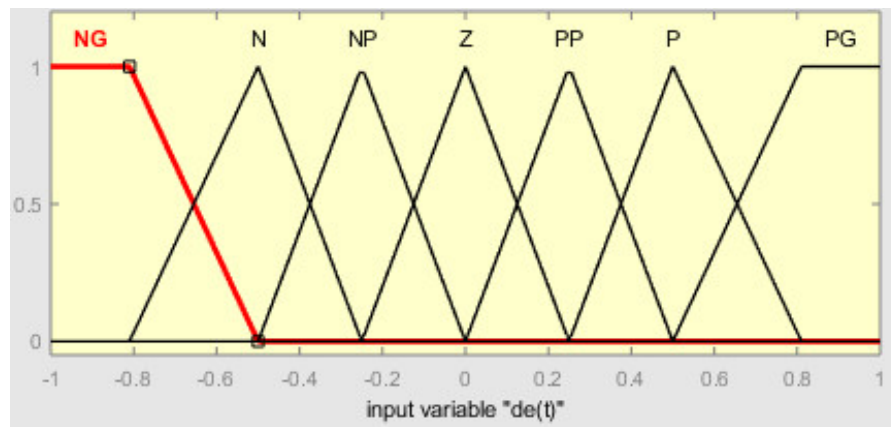
Figure 14. Membership functions and universe of discourse of the error derivative input signal.